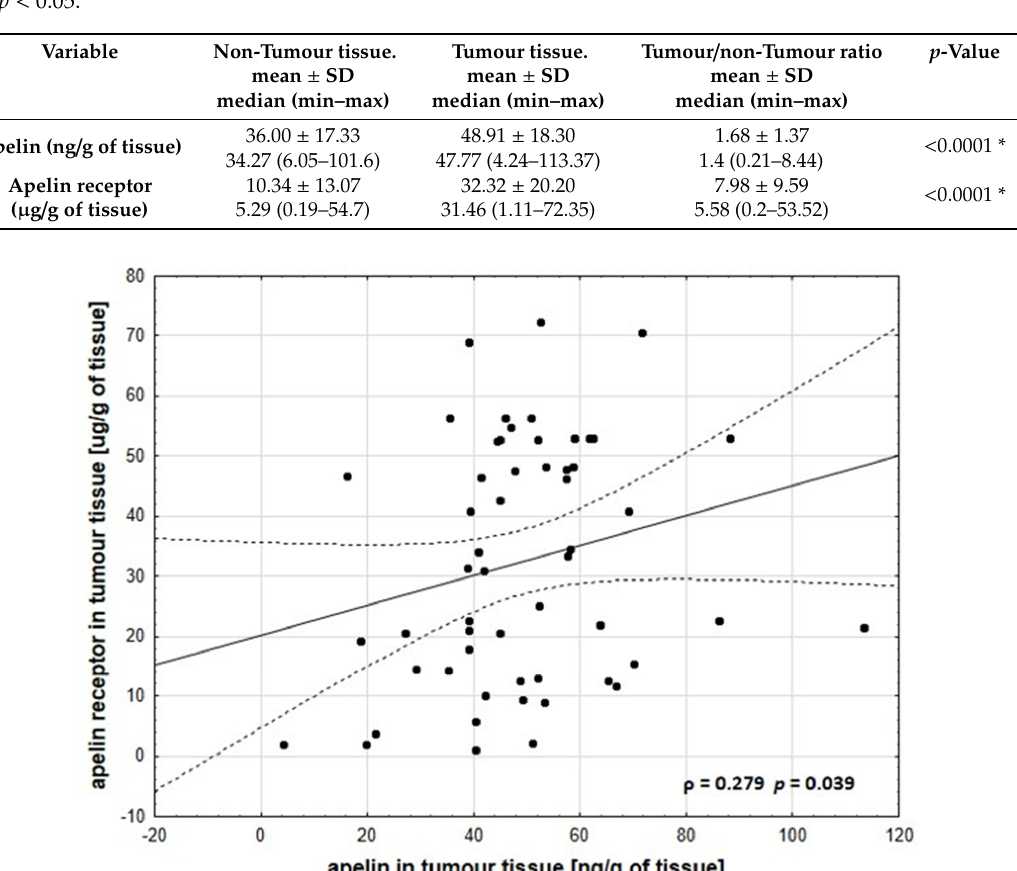
Figure 1. Positive correlation between apelin and its receptor levels in the tumour tissues of CRC patients. These data were analysed using the Spearman’s rank correlation coefficient ( ρ ).